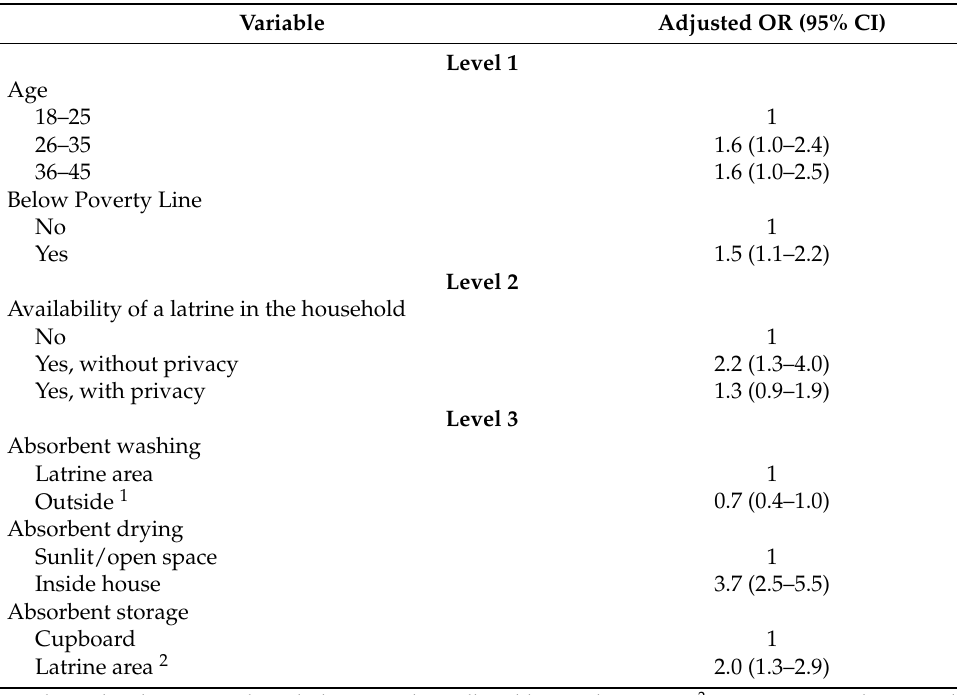
Table 5. Final hierarchical model for VVC. Values represent odds ratios with confidence intervals in parentheses. Odds ratios are adjusted for variables in the same and preceding levels. Age group was included a priori confounding factor in the models at every